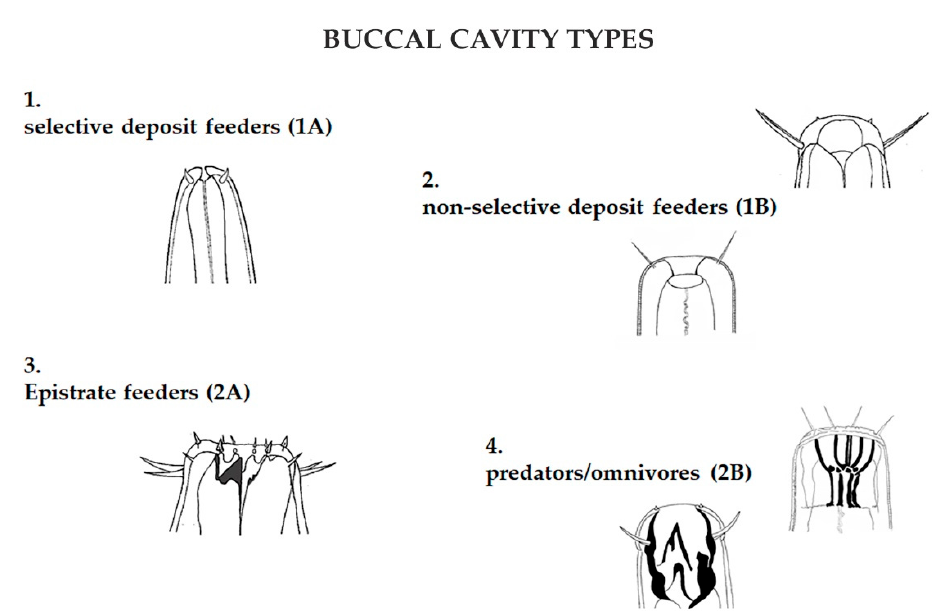
Figure 4. Buccal cavity morphologies reflect the trophic role of the species in the ecosystem: selective (1A) and non-selective (1B) deposit feeders, epistratum feeders (2A), and predators/omnivores (2B).